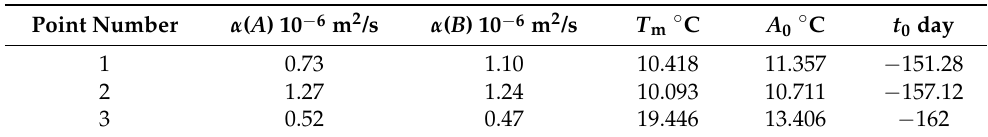
Table 4. Values of the thermal diffusivities α ( A ) and α ( B ), and other parameters of Equation (10) for measurement points No. 1, No. 2, and No.